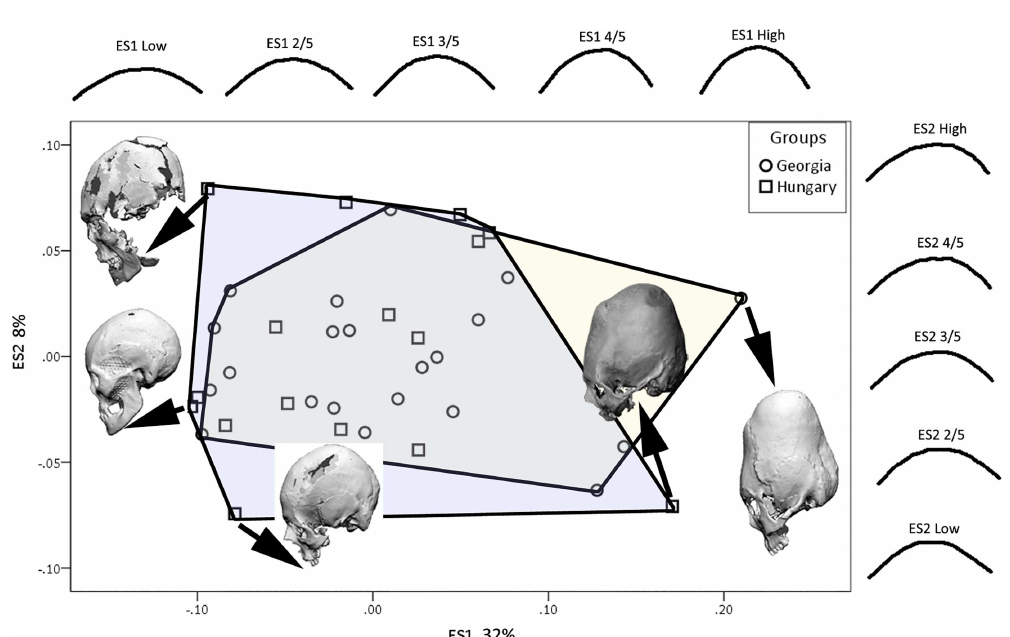
Fig 11. Eigenscores for the parietal outline plotted on ES1 and ES2 with convex hulls highlighting each group, also showing shape changes along the first and second morphospaces, and example crania demonstrating the